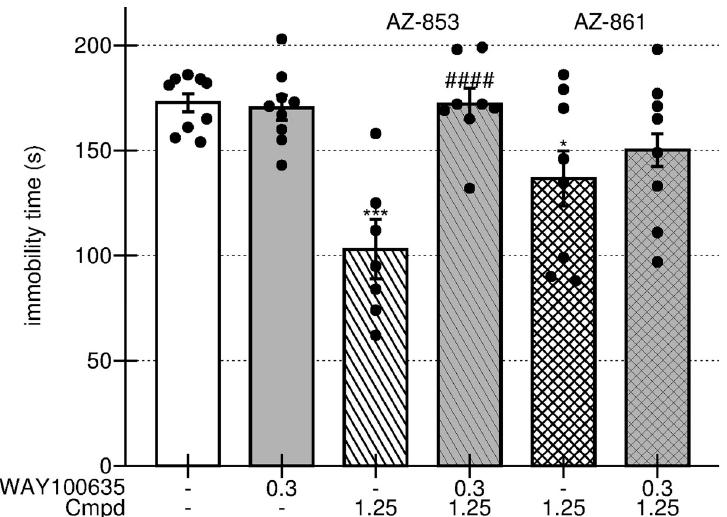
Fig 4. Effect of WAY-100635 administration on antidepressant-like activity of AZ-853 and AZ-861 on FST in mice. Data represent mean ± SEM, n = 7–9 mice per group; two-way ANOVA followed by Bonferroni’s post hoc test; � p < 0.05, ��� p < 0.001 vs. control group, ####p < 0.0001 vs. respective compound-treated group. Cmpd–the respective tested compound.